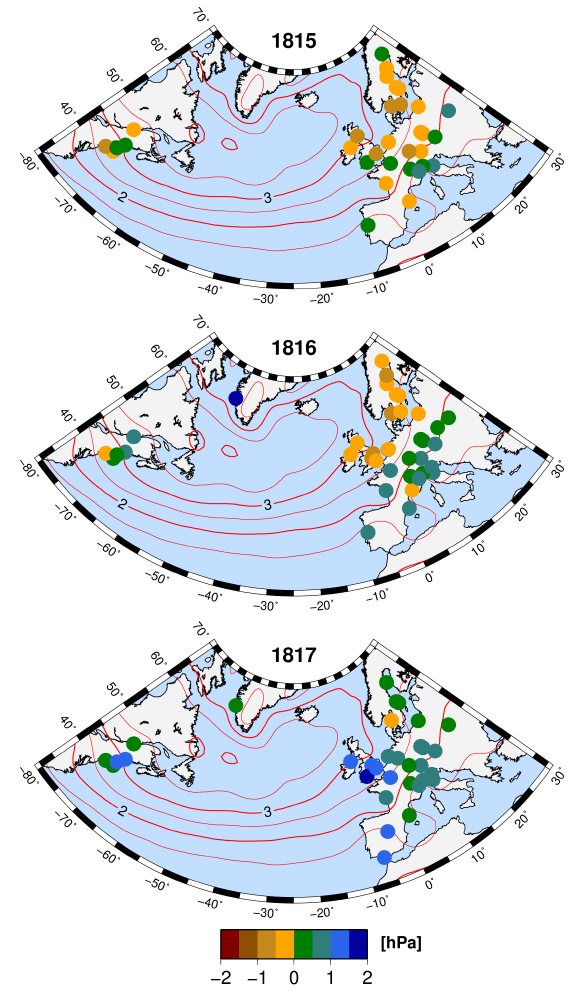
Figure 7. Similar to Fig. 6 but for summer (120-day period starting on 18